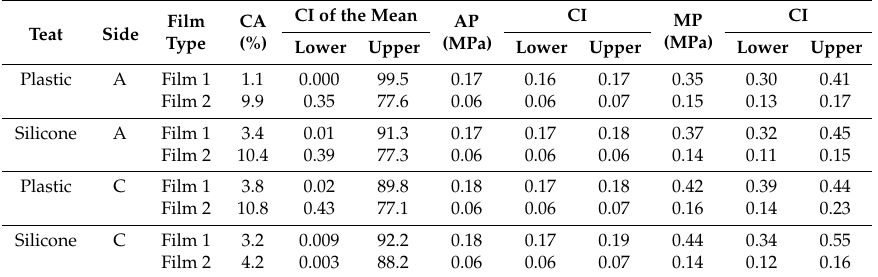
Table 3. Colored area (CA), average pressure (AP), and maximum pressure (MP) with 95% confidence intervals (CI) by artificial teat, side of attachment (Side A or Side C directly on the teat), and film type after bending of the pressure-indicating